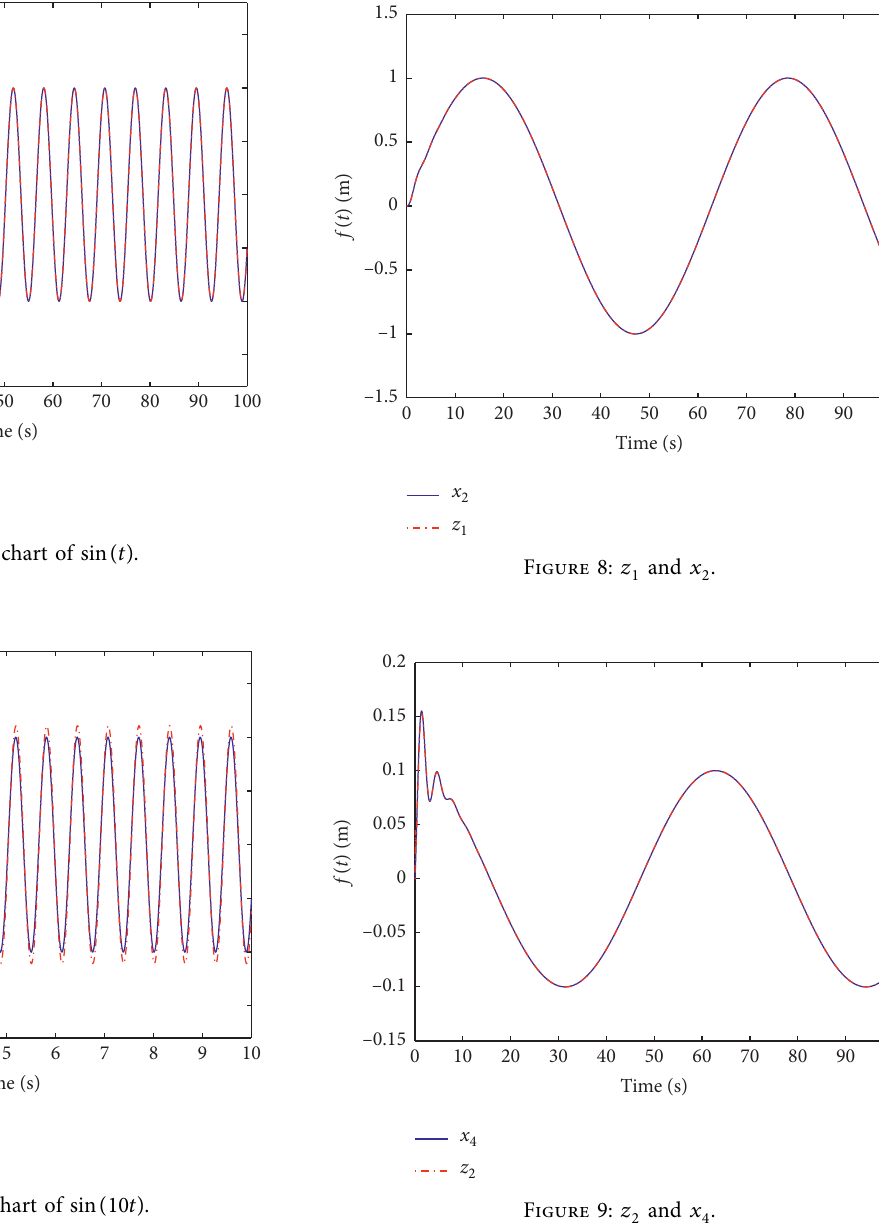
Figure 9: z and x 2 4